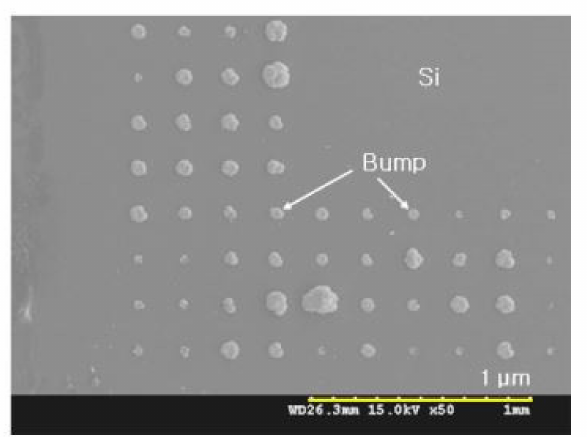
Figure 15. Irregular bump on unevenly filled Cu via in non-PR pumping